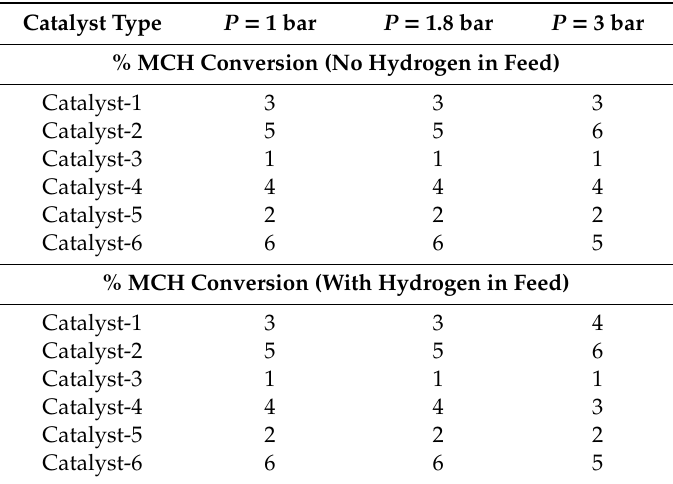
Table 7. Rankings of the catalyst for operating